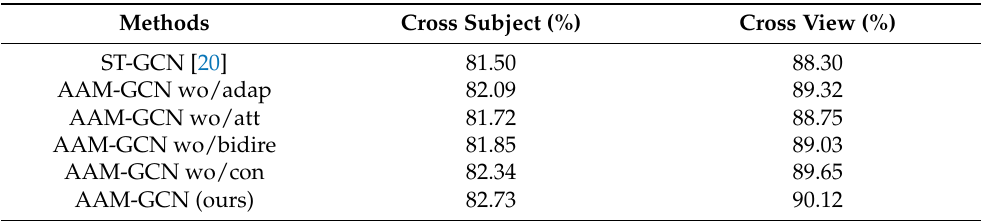
Table 5. Ablation experiments on the NTU RGB+D dataset. “ST-GCN” [20] is compared as a baseline method. For the setting of each method, please refer to Section